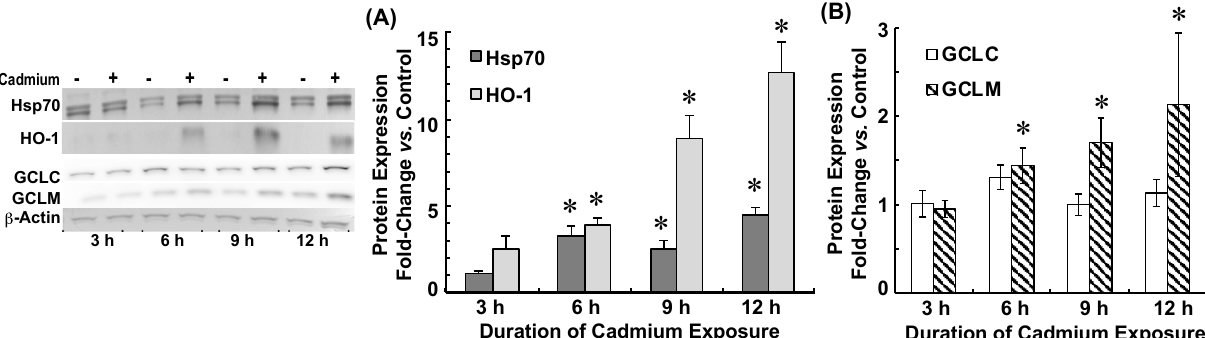
Figure 3. Time-dependent heat shock protein-70 (Hsp70) and heme oxygenase (HO-1) protein expression ( A ) and GCLC and GCLM protein expression ( B ) in choroid plexus epithelial cells exposed to 500 nM CdCl 2 . Non-zinc supplemented cells were pre-treated (12 h) in serum-free medium (SFM) and divided into two sets: one set was incubated in SFM without CdCl 2 , while the other was exposed to 500 nM CdCl 2 in SFM (Cd). All treatments were performed at 37 °C. At 3, 6, 9, and 12 h, representative cadmium-exposed and time-matched control cells were collected for immunoblot analysis of proteins of interest and β -actin. A representative immunoblot is shown. Immunoreactivity of each protein with the respective primary antibody was visualized by colorimetric or enhanced chemiluminescence detection. Protein band intensity was normalized to that of β -actin; induction was expressed as fold-change versus time-matched control. Protein expression was analyzed in five separate culture preparations; data are means ± SE; n = 5. * p < 0.05 vs. time-matched Control.